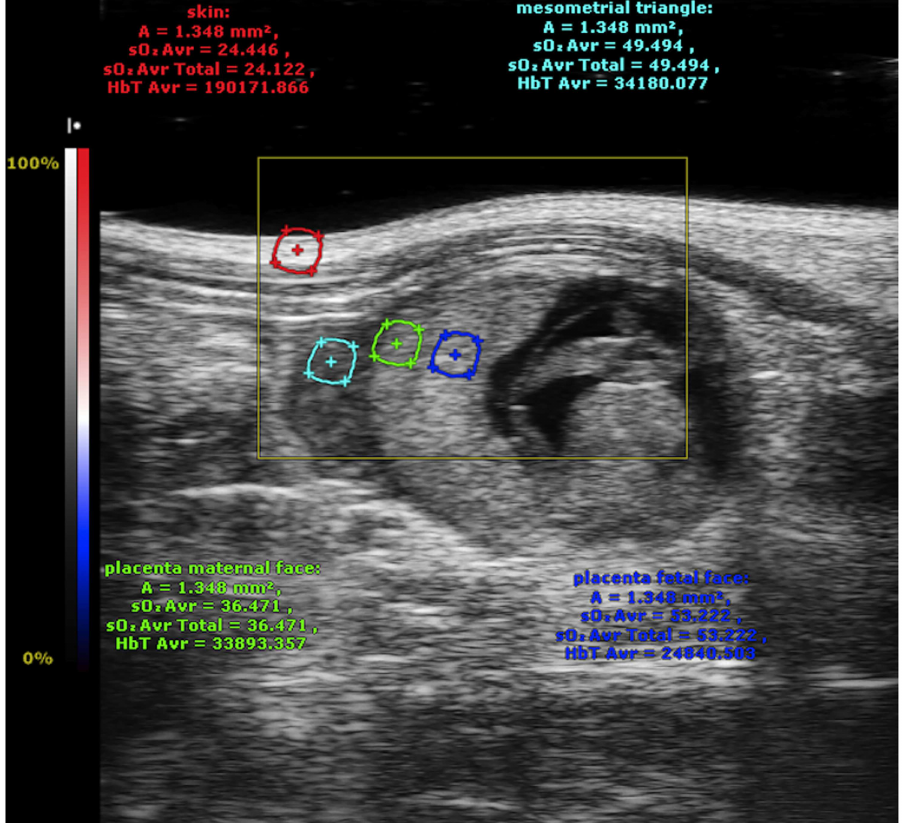
Fig 2. Regions of interest (ROIs) placed on the skin (red), the mesometrial triangle (light blue), and the two different zones of the placenta: the basal zone (green) and the labyrinth zone (dark blue).